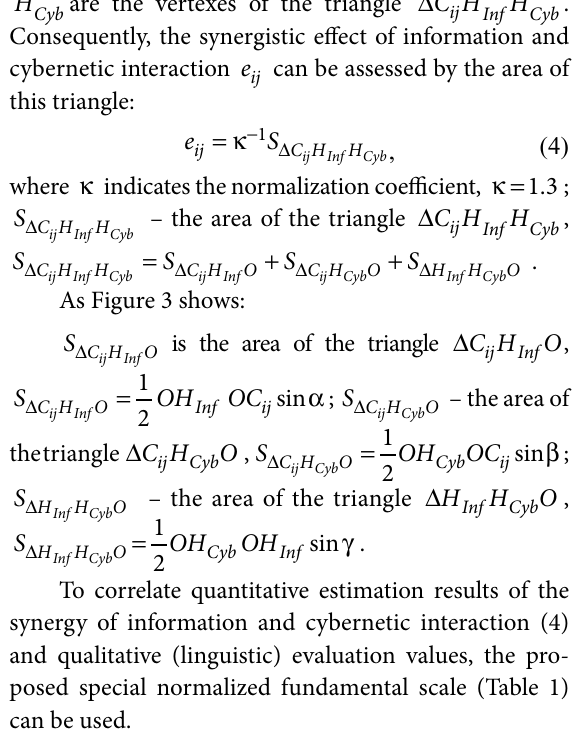
Table 1. Normalized fundamental scale for synergistic effect assessment Level